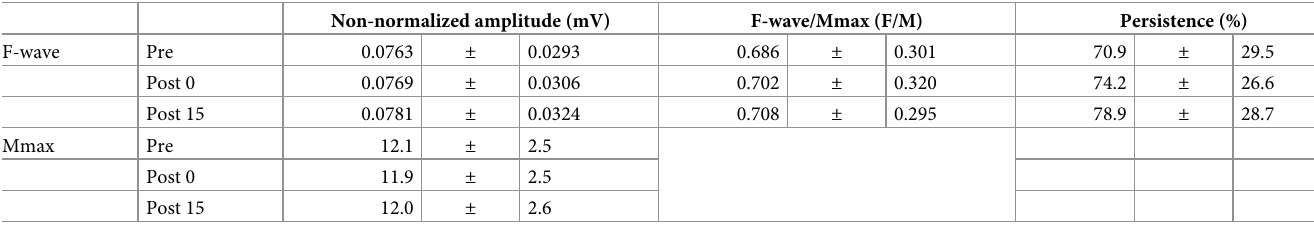
Table 3. Average non-normalized amplitudes of F-wave and Mmax, F/M, and persistence of F-wave with SDs in the REST condition before intervention (Pre), immediately after intervention (Post 0), and 15 min after intervention (Post 15).